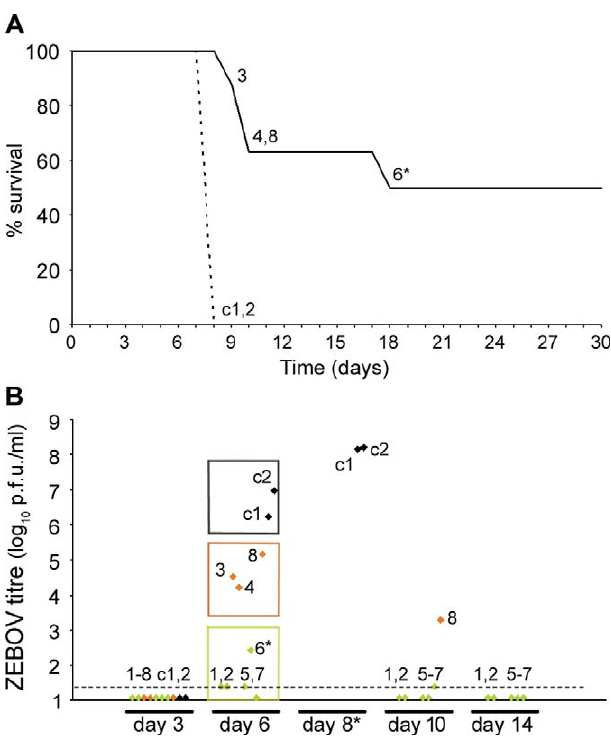
Figure 2. Survival and Plasma Viraemia for Rhesus Monkeys Given Post- Exposure Treatment for ZEBOV Infection (A) Kaplan-Meier survival curves for animals treated with ; 2 3 10 7 pfu of VSV D G/ZEBOVGP (subjects 1 to 8, solid line) or VSV control vectors (subjects c1 and c2, dotted line) 20–30 min after i.m. challenge with 1,000 pfu of ZEBOV. (B) Plasma viraemia of animals treated with VSV D G/ZEBOVGP or VSV control vectors 20–30 min after i.m. challenge with 1,000 pfu of ZEBOV.